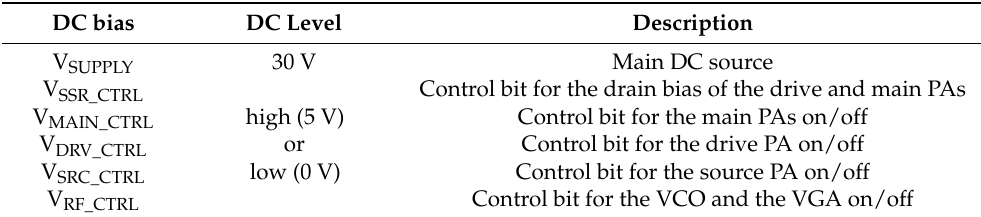
Table 1. Description of the external DC biases.